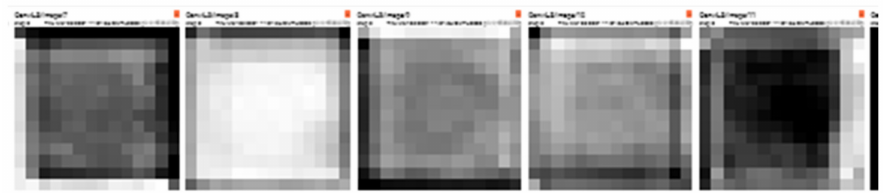
Figure 6. Interferences caused by padding (Convolutional Layer